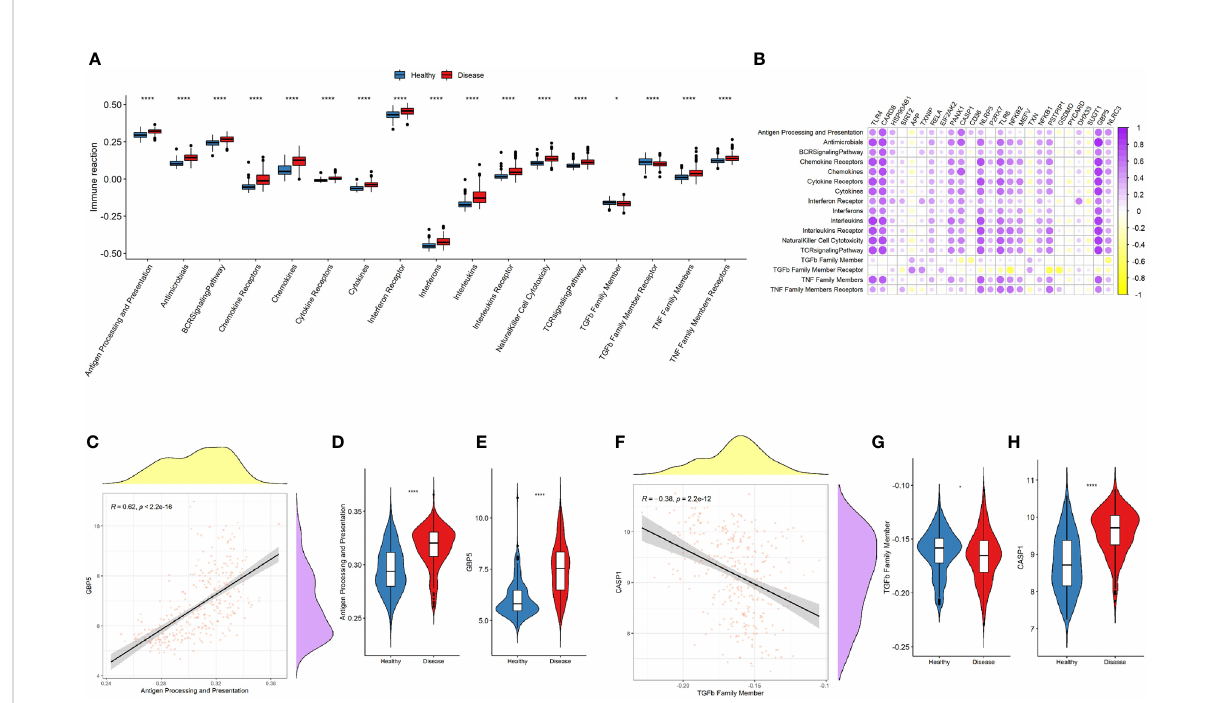
FIGURE 6 NLRP3 in fl ammasome-related genes and immune-related pathways. (A) Comparison of immune-related pathway activations between the two groups. (B) Correlation plot showing signi fi cant correlations between the genes and immune-related pathways. Purple: positive correlation. Yellow: negative correlation. Circles with deeper colors indicate stronger correlations. (C) Correlation between GBP5 expression and antigen processing and presentation pathway. (D, E) Violin plots showing the levels of antigen processing and presentation pathway (D) and GBP5 expression (E) in two groups. (F) Correlation between CASP1 expression and TGF b family member. (G, H) Violin plots showing the levels of TGF b family member (G) and CASP1 expression (H) in two groups. R represents Pearson correlation coef fi cients. *: P < 0.05; **** P ≤